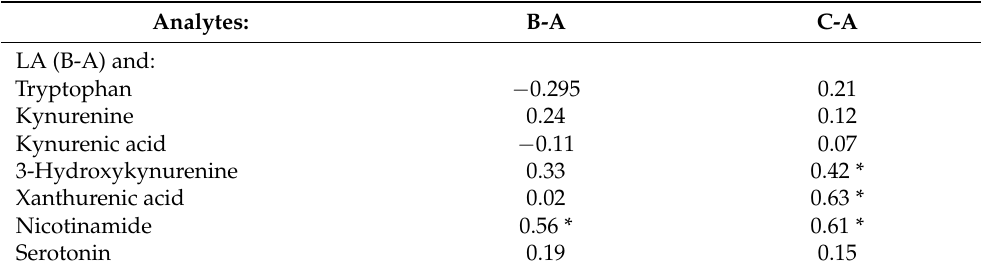
Table 2. Correlations between exercise-induced changes in plasma LA (B-A) and other analytes determined in all horses studied (n = 36).